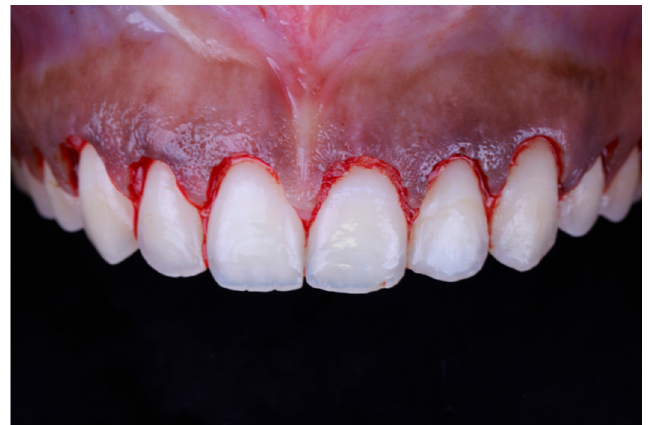
Figure 6. Tooth length after gingival excision.